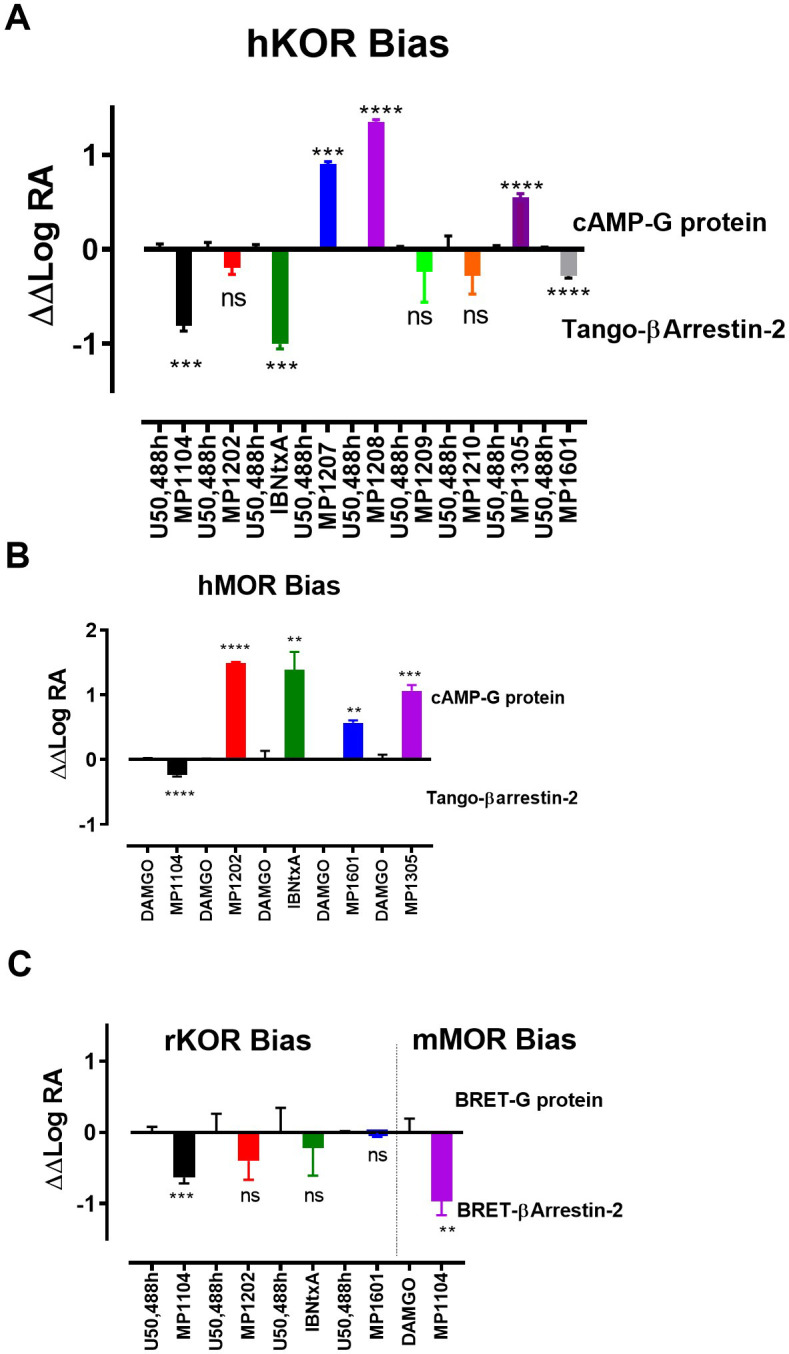
Bias plots for ligands at hKOR (A), hMOR (B) using cAMP and Tango assay and at rKOR /mMOR (C) using BRET assays.Bias analysis for signaling was performed as described in Materials and methods. Data analyzed against DAMGO and/or U50,488h for each ligand using unpaired t-test with Welch’s correction. At hKOR, MP1104 (**p=0.0015); IBNtxA (***p=0.0002) showed preference for arrestin over G-signaling while MP1209, 1210, 1305 and 1601 showed no preference for any signaling pathway. MP1209 (***p=0.0001) and MP1208 (****p<0.0001) were G-biased. At hMOR, MP1104 (*p=0.0427) preferred arrestin pathway while MP1202 (****p=<0.0001); IBNtxA (**p=0.0089); MP1601 (**p=0.0017) and MP1305 (***p=0.001) were G-biased. At rKOR, MP1104 (***p=0.0002) preferred arrestin pathway while IBNtxA, MP1202, 1601 and 1305 showed no preference for any signaling pathway. At mMOR, MP1104 (**p=0.0021) showed preference for arrestin pathway. To summarize bias factors suggest that in spite of differences in assays and species tested, ligands which engage TM5-ECL2 region of MOR/KOR and where ringC takes chair conformation.